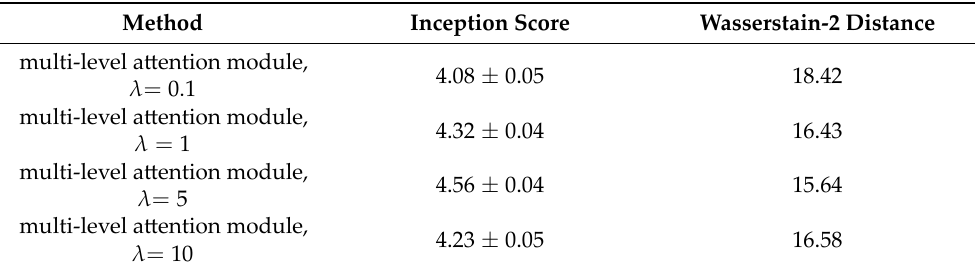
Table 4. Test results under different super‑parameters of DAMSM impact